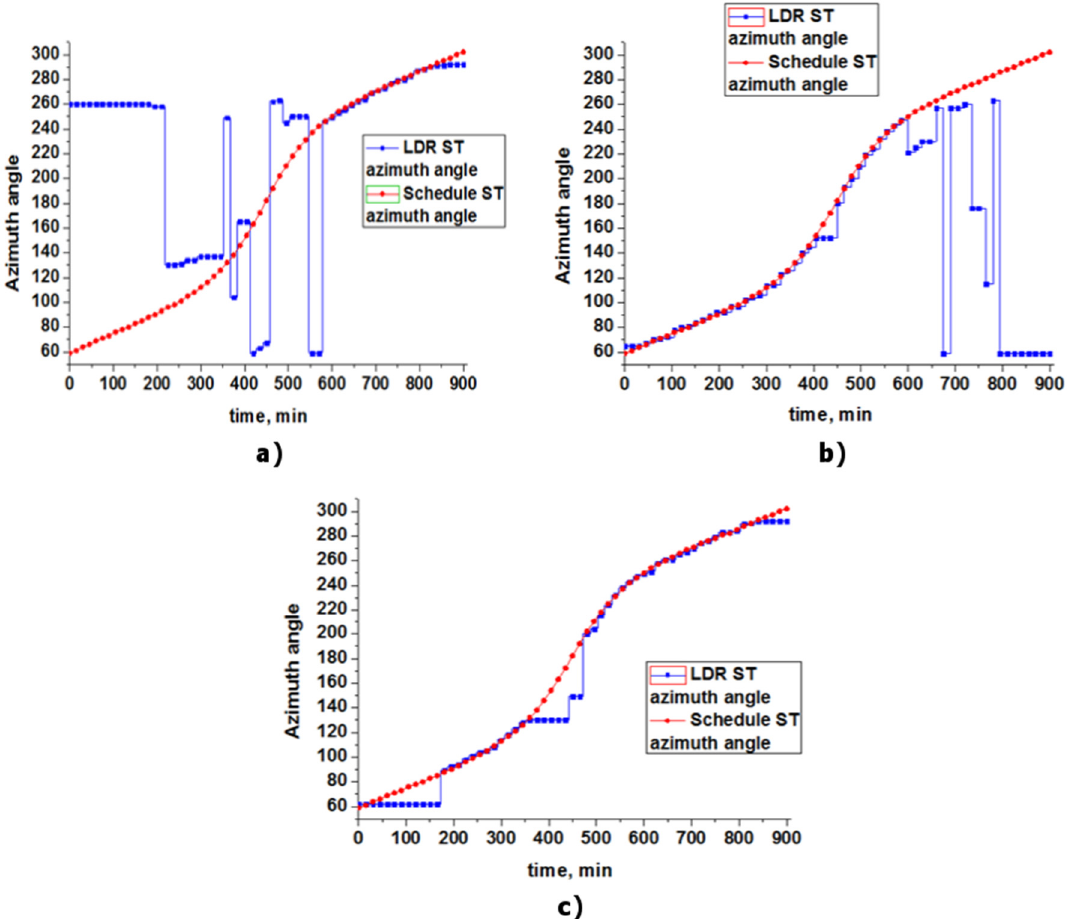
Figure 11. The azimuthal angles of the trackers: ( a ) 1 July 2020, ( b ) 2 July 2020, ( c ) 9 July 2020.